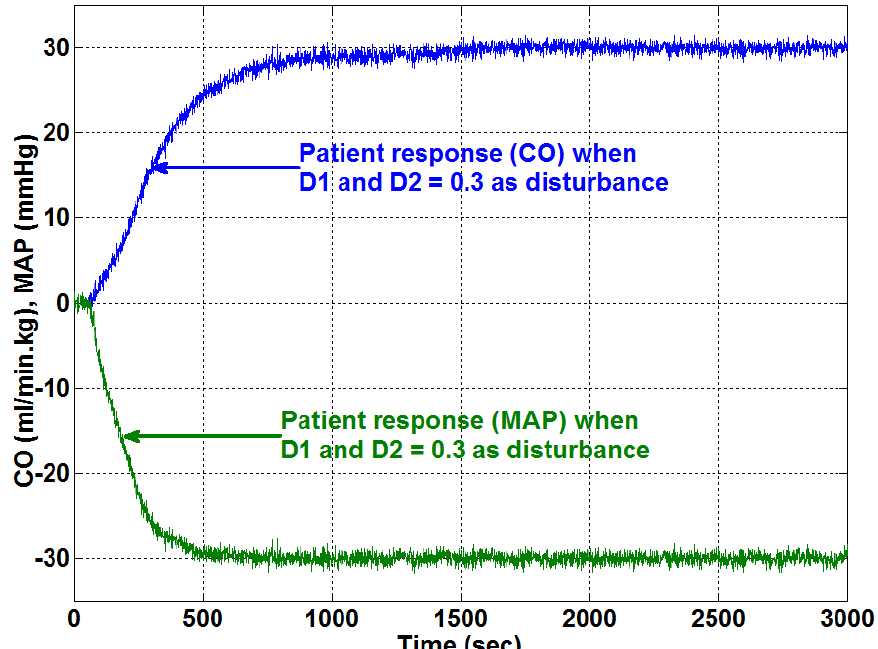
Figure 14: Nominal response with disturbance variance D1=D2=0.3 and set points +30 for CO and -30 for